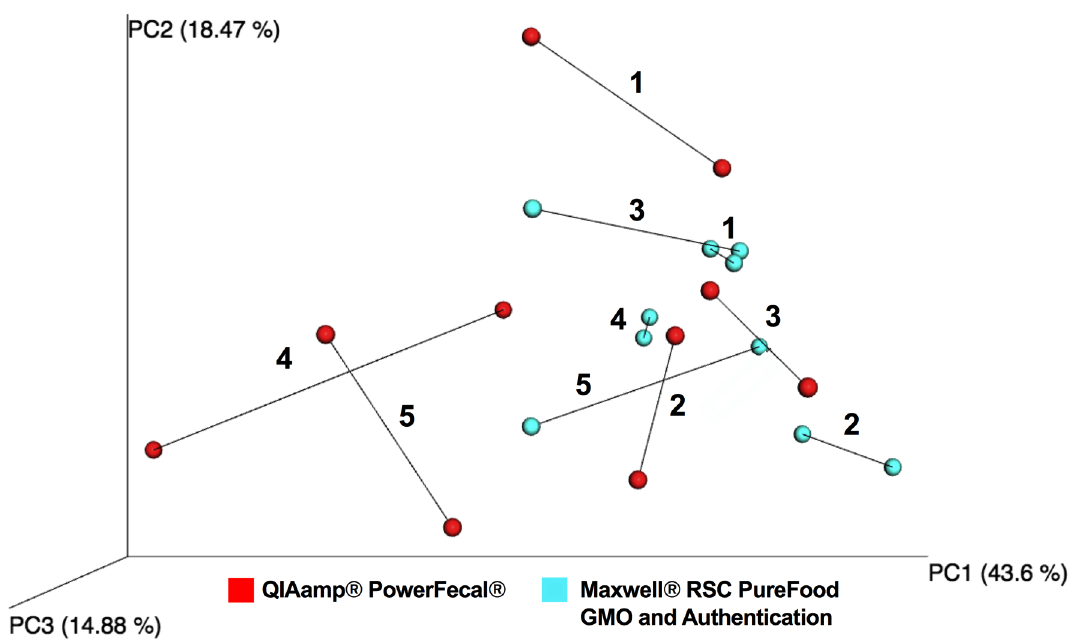
Fig 6. Procrustes-based comparison of microbial composition where longer lines indicate more within-subject dissimilarity of the microbiome. Colors denote DNA extraction method: QIAamp 1 PowerFecal 1 Kit ( red ) and Maxwell 1 RSC PureFood GMO and Authentication Kit ( blue ). Numbers 1–5 denote the 5 technical replicate pairs sequenced with each